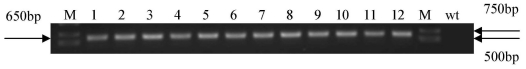
1 to 12, PCR analysis of 35S::AcPI transgenic Arabidopsis plants using primers PImq-F and PImq-R. A 650 bp DNA fragment was amplified. M, Marker DL2000. wt, PCR analysis of wild type plant using the same primers.